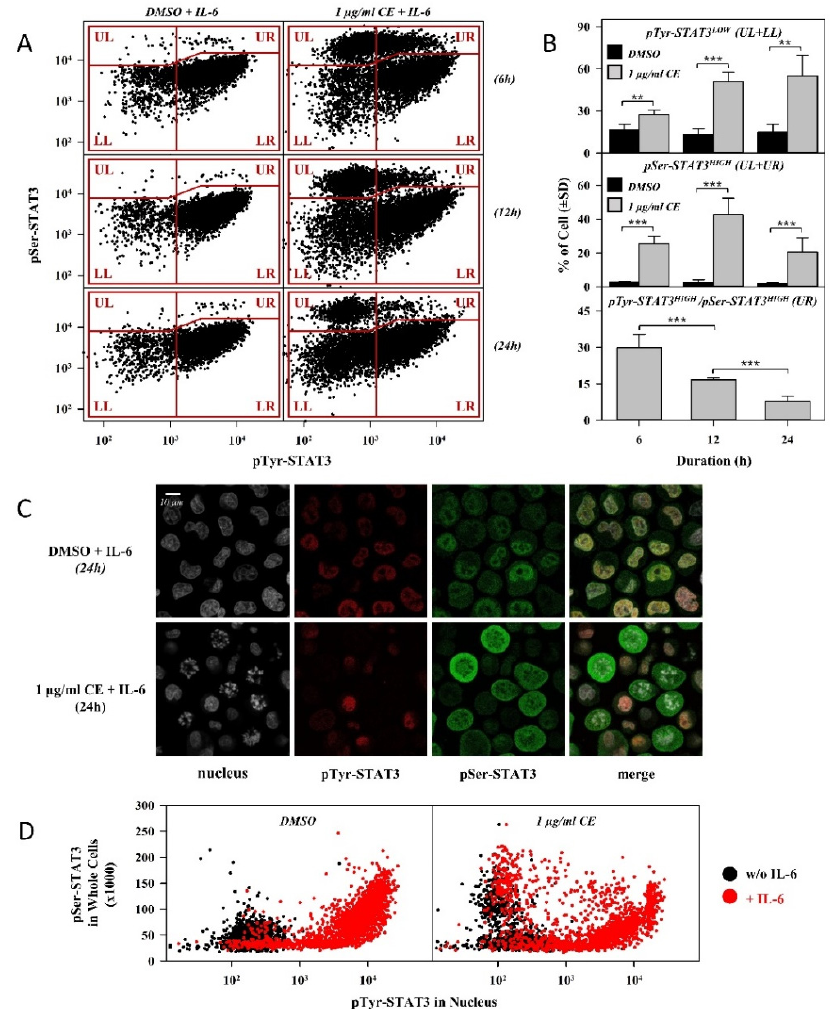
Figure 3. Subpopulations of OCM-1 cells with reduced IL-6 responsiveness and elevated pSer-STAT3 level overlap partially with each other. ( A ) Representative flow cytometry dot plots of pSer-STAT3 vs. pTyr-STAT3 levels in OCM-1 cells incubated for the indicated durations with chelidonine (right panels) or DMSO (left panels). n = 10,000 cells/sample were measured. Before analysis, cells were stimulated with IL-6 (20 ng/mL, 30 min) and labeled with Alexa Fluor 647- and PE-conjugated mAbs targeting pTyr-STAT3 and pSer-STAT3. (UL: upper left, UR: upper right, LL: lower left, LR: lower right) ( B ) Time dependence of the effects of chelidonine on the phosphorylation state of STAT3 in OCM-1 cells. The top and middle panels show the fraction of IL-6 unresponsive cells (in terms of STAT3 activation, pTyr-STAT3 LOW ) and that of cells with elevated pSer-STAT3 levels (pSer-STAT3 HIGH ), respectively, for DMSO- (black bars) and chelidonine-treated (grey bars) cells. The bottom panel depicts the fraction of cells with elevated pSer-STAT3 levels, induced by chelidonine treatment, which are still responsive to IL-6-induced tyrosine phosphorylation (pTyr-STAT3 HIGH / pSer-STAT3 HIGH ) (UL, UR, LL and LR refer to the respective fractions of cells in part A). The per- centage of cells was determined with quantitative analysis of flow cytometry dot plots shown in part A. Percentages are expressed as mean ± SD values for at least three independent experiments, p -value < 0.001 (***) or < 0.01 (**). ( C ) Confocal microscopy images depict subcellular localization of pTyr- and pSer-STAT3 in DMSO- (top panels) and chelidonine-treated (bottom panels) cells. Images in the first column show nuclei stained with DAPI (grey), whereas images in the second and third columns represent subcellular distribution of pTyr-STAT3 (red) and pSer-STAT3 (green). Overlay images (last column) show co-localization of the labels. For microscopy experiments, cells were cul- tured in the presence of chelidonine or DMSO for 24 h and then processed as described in part A. ( D ) Representative dot plots demonstrate the correlated levels of nuclear pTyr-STAT3 and whole cell pSer-STAT3 in DMSO- (left panel) and chelidonine-treated cells (right panel) with and without IL-6 stimulation (red and black dots, respectively). Fluorescence intensities, representing average